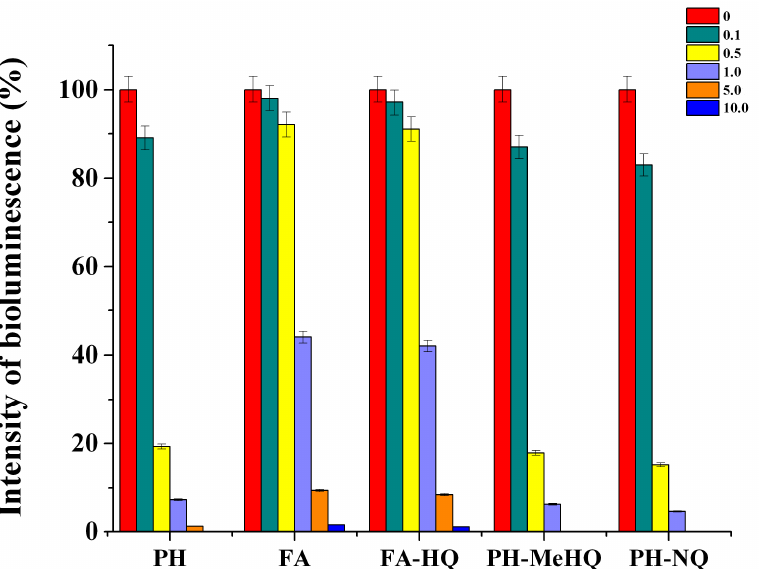
Figure 4. Influence of various HC and their concentrations (g/L) on the intensity of recorded bioluminescence when they are introduced into the reaction medium with luciferin-luciferase reagent and standard ATP samples. Basically the difference in the mean values among the treatment groups was statistically significant according one-way ANOVA ( p < 0.05).